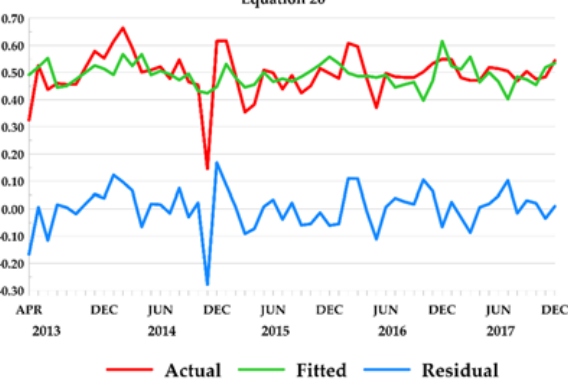
Figure 13. Representation for olive, estimation model and the residuals given by Equation (26). The forecast model is constructed as a combination of models presented in Equations (25) and (26). The combination of the models was obtained through least squares and mean squares, with a resulting MSE of 0.003 and 0.003, respectively. Figure 14 presents the forecast values for a one-year time horizon given by the estimation models pre- sented in Equations (25) and (26) and least squares and mean squares aggregation models. The associated MSEs for each estimation model presented in Equations (25) and (26) were 0.005 and 0.006. The best forecast model attending to the best MSE value was obtained by least squares.